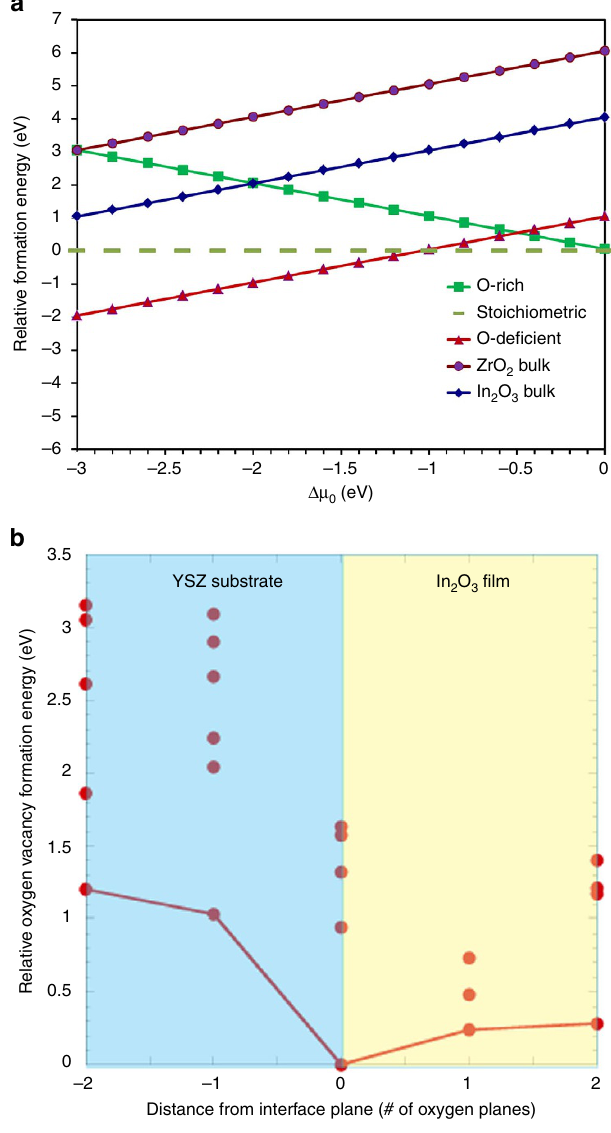
Figure 8 | Oxygen vacancy formation energies. ( a ) Relative formation energy per oxygen vacancy for several interface configurations and bulk vacancies in ZrO 2 and In 2 O 3 as a function of oxygen chemical potential relative to molecular oxygen. The zero energy reference is the corresponding stoichiometric structure. ( b ) On the basis of first-principles calculations, the formation energy associated with adding an oxygen vacancy to a YSZ-In 2 O 3 supercell is predicted to be significantly lower for sites in the interface plane or adjacent to the interface in the In 2 O 3 film than for sites in the YSZ substrate. Energies for multiple possible sites for an oxygen vacancy within each plane are shown. Points connected with a line correspond to the lowest energy positions of the vacancy in each plane. The formation energy values are relative to the energy of the lowest energy site in the